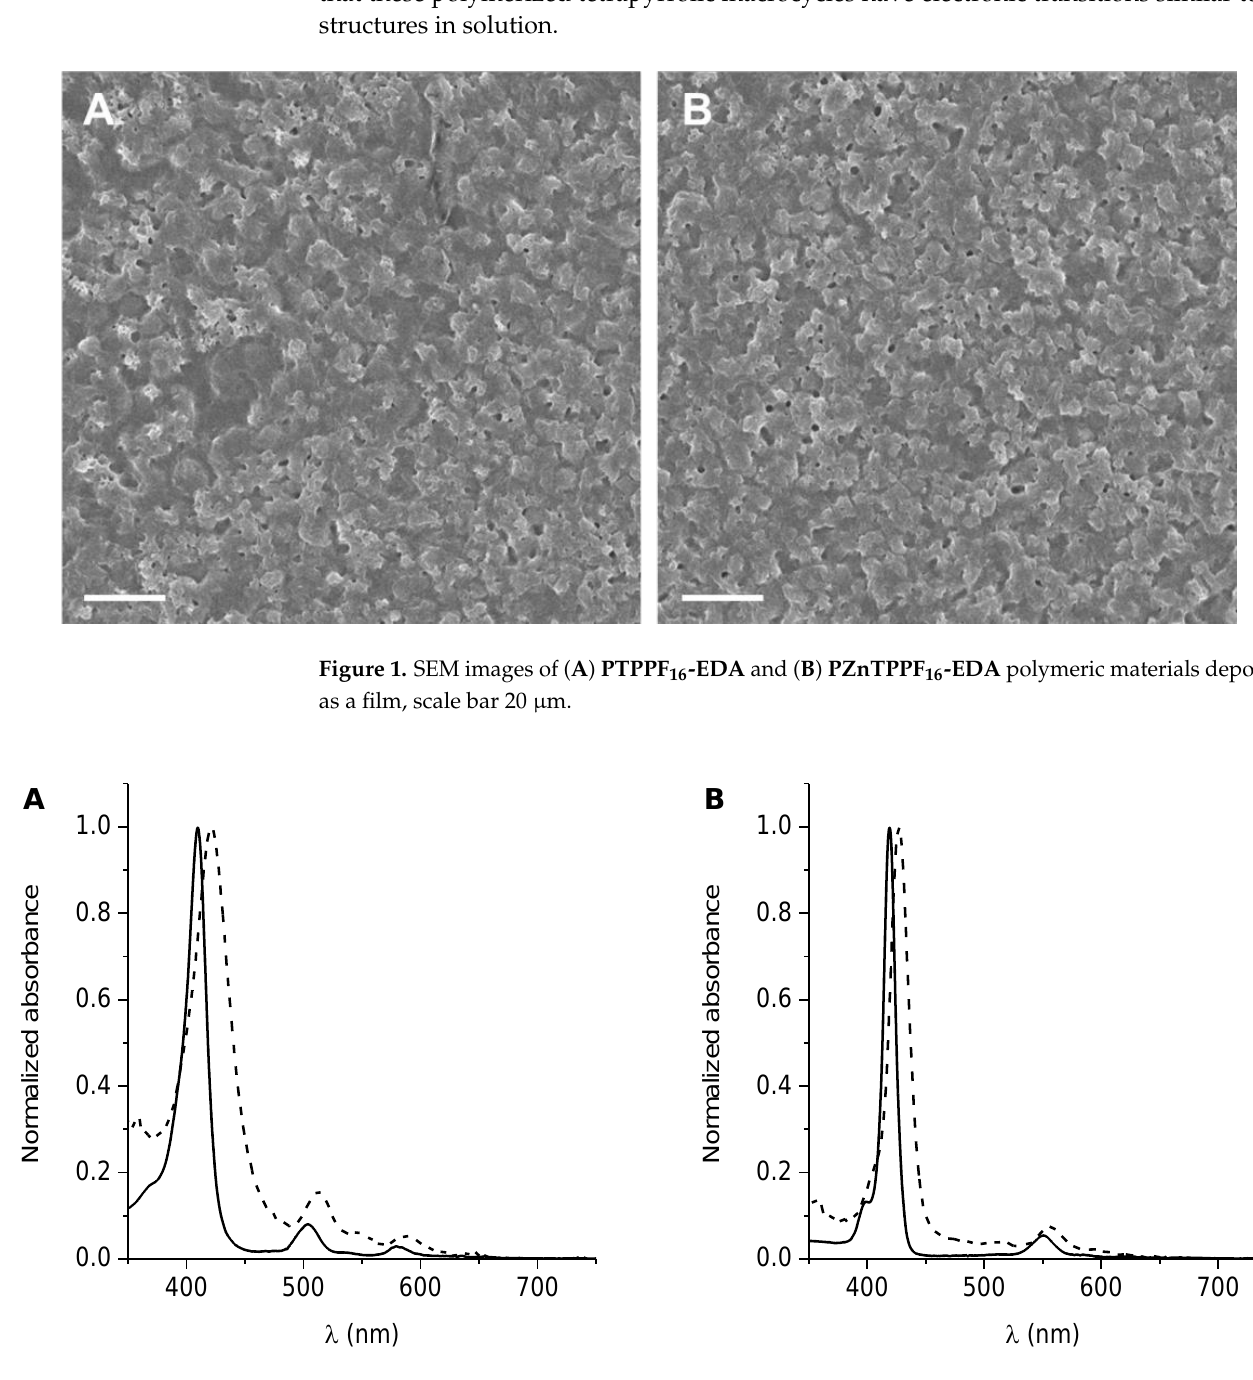
Figure 2. UV-visible absorption of ( A ) TPPF 20 (solid line) and PTPPF 16 -EDA (dashed line) and ( B ) ZnTPPF 20 (solid line) and PZnTPPF 16 -EDA (dashed line) in DMF.